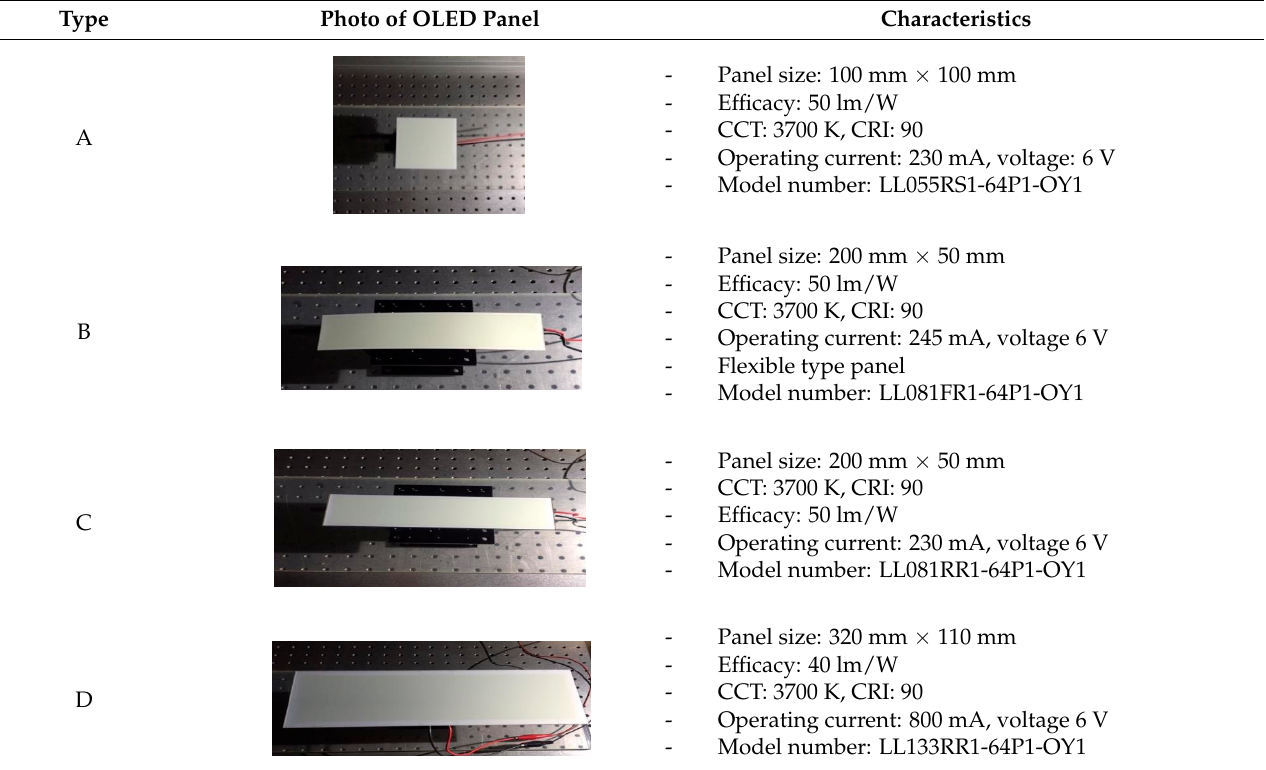
Table 1. Organic light-emitting diode (OLED) panels used in the experiment.